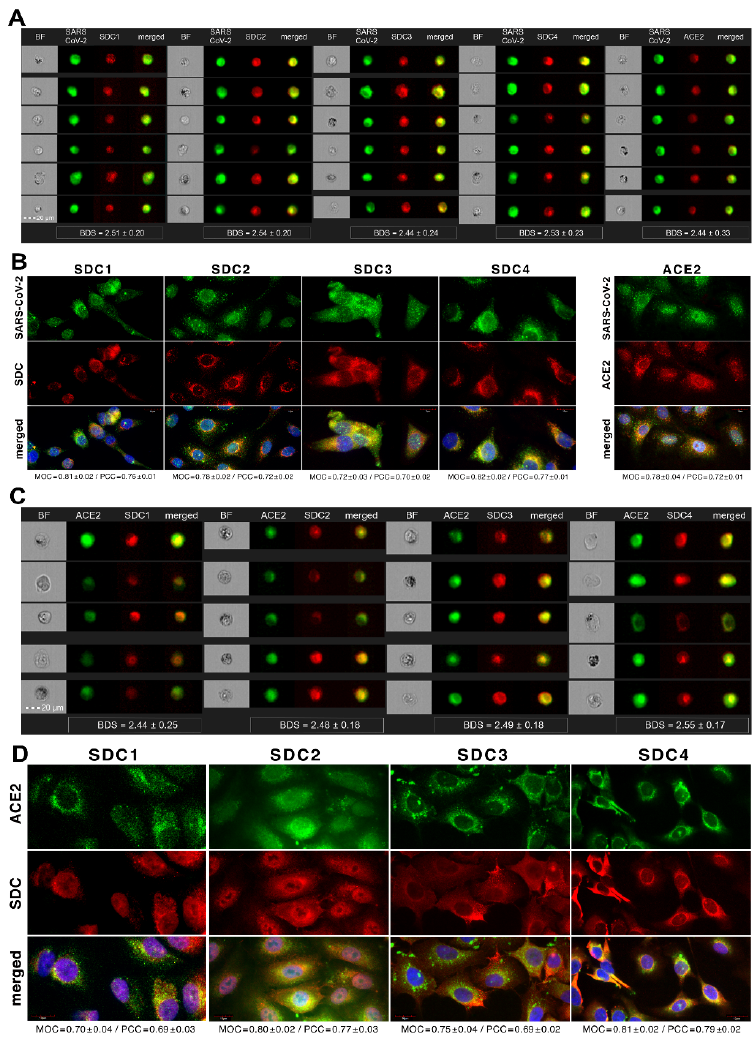
Figure 5. SARS-CoV-2 colocalizes with both SDCs and ACE2 during its uptake in A549 cells. WT A549 cells were incubated with heat-inactivated SARS-CoV-2 (at 1 MOI) for 18 h at 37 °C. After incubation, the cells were treated with, in case of the SARS-CoV-2/SDC colocalization studies, antibodies specific for the spike glycoprotein (along with AF 488-labeled secondary antibody) and APC-labeled SDC antibodies. Colocalization of SARS-CoV-2 and ACE2 was analyzed by using AF 647-labeled antibody against ACE2. For analyzing colocalization between SDCs and ACE2, the SARS-CoV-2-treated cells, after incubation, were treated with AF 488-labeled antibodies against ACE2 and APC-labeled SDC antibodies. Colocalization of SARS-CoV-2 with SDCs and ACE2, or SDCs with ACE2, was then analyzed with imaging flow cytometry and confocal microscopy. ( A ) Imaging flow cytometry visualization of colocalization between SARS-CoV-2 and SDCs and ACE2 in SARS-CoV-2-treated A549 cells. Representative images of four independent experiments are shown. Scale bar = 20 μm. BDS of SARS-CoV-2 and SDCs (or ACE2) represent the mean ± SEM of four independent experiments. Statistical significance between the groups was assessed with ANOVA (no statistically significant differences were detected). ( B ) Confocal microscopy visualization of colocalization between SARS-CoV-2 and SDCs or ACE2 in SARS-CoV-2-treated WT A549 cells. Representative images of four independent experiments are shown. Scale bar = 10 μm. MOC ± SEM and PCC ± SEM for the overlap and colocalization of SARS-CoV-2 with either of the SDC isoforms and ACE2 (indicated below each image) were calculated by analyzing 15 images with ~10 cells in each image (from 3 separate samples). ( C ) Imaging flow cytometry visualization of colocalization between ACE2 and SDCs in SARS-CoV-2-treated WT A549 cells. Representative images of four independent experiments are shown. Scale bar = 20 μm. The indicated BDS of ACE2 and SDCs represent the mean ± SEM of four independent experiments. ( D ) Confocal microscopy visualization of colocalization between ACE2 and SDCs in SARS-CoV-2-treated WT A549 cells. Representative images of four independent experiments are shown. Scale bar = 10 μm. MOC ± SEM and PCC ± SEM for the overlap and colocalization of ACE2 and SDCs (indicated below each image) were calculated by analyzing 15 images with ~10 cells in each image (from 3 separate samples).